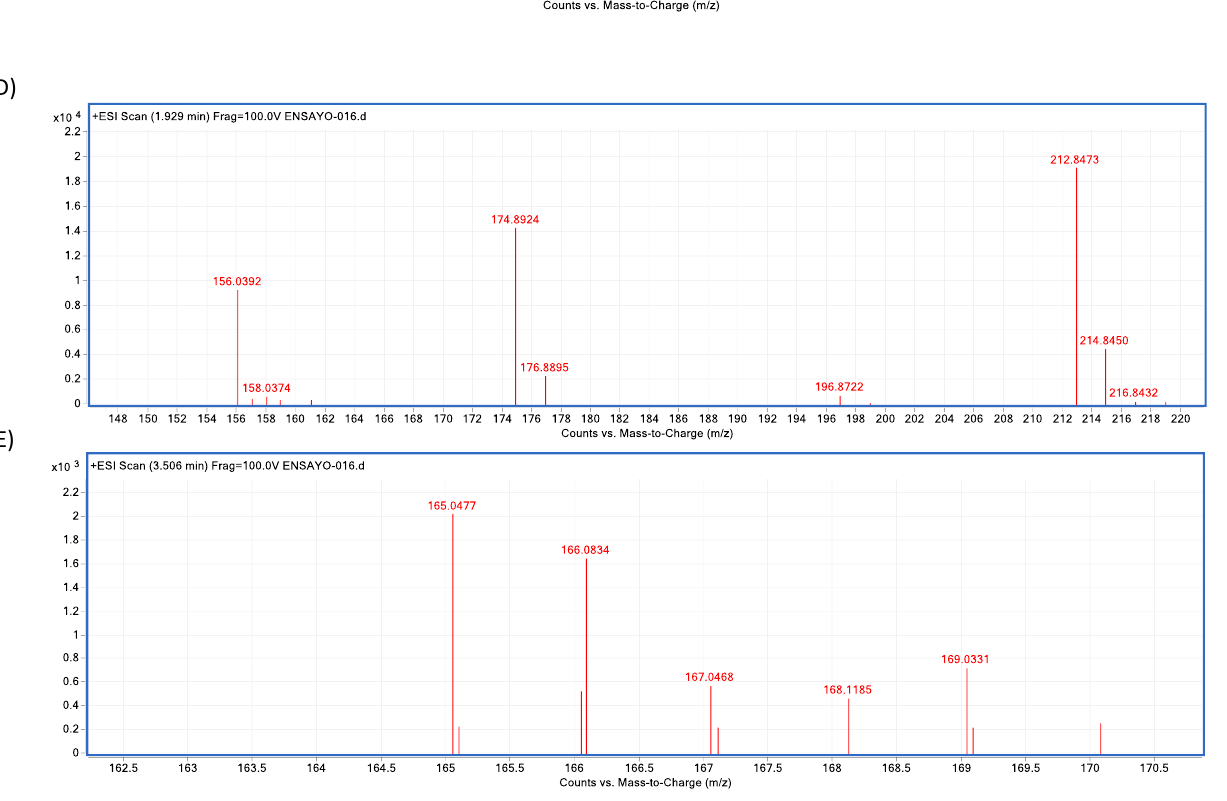
Figure 24. Neutral metalloendopeptidase – OTA biotransformation HPLC – TOF – MS chromatograms showing: ( A ) Ochratoxin (OTA) control peak; ( B ) Ochratoxin (OTA) peak is not present in tested tubes (red = control; brown line = tested tube); ( C ) OTA’s molecular ion as found in control tubes (M + 1) at 404.05 ( m / z ); ( D ) molecular ion (M + 1) of the most stable product of α -ochratoxin fragmentation at 212.84 ( m / z ); ( E ) Phenylalanine molecular ion (M + 1) at 166.08 ( m / z ) final product of OTA biotransformation by neutral metalloendopeptidase, as found in tested tubes.